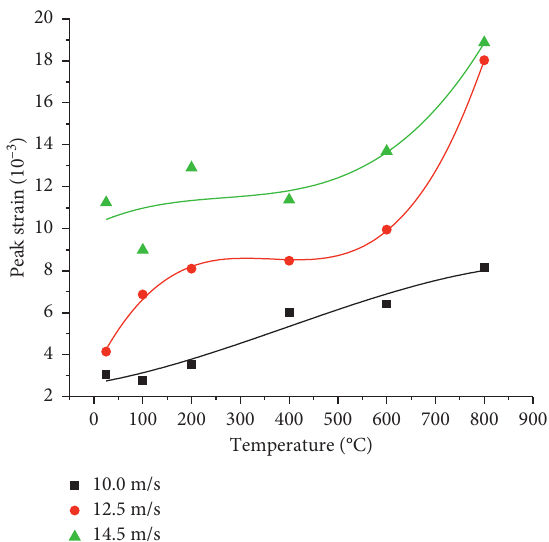
Figure 15: Peak stress-temperature curves of rock under different impact speeds and different temperatures.